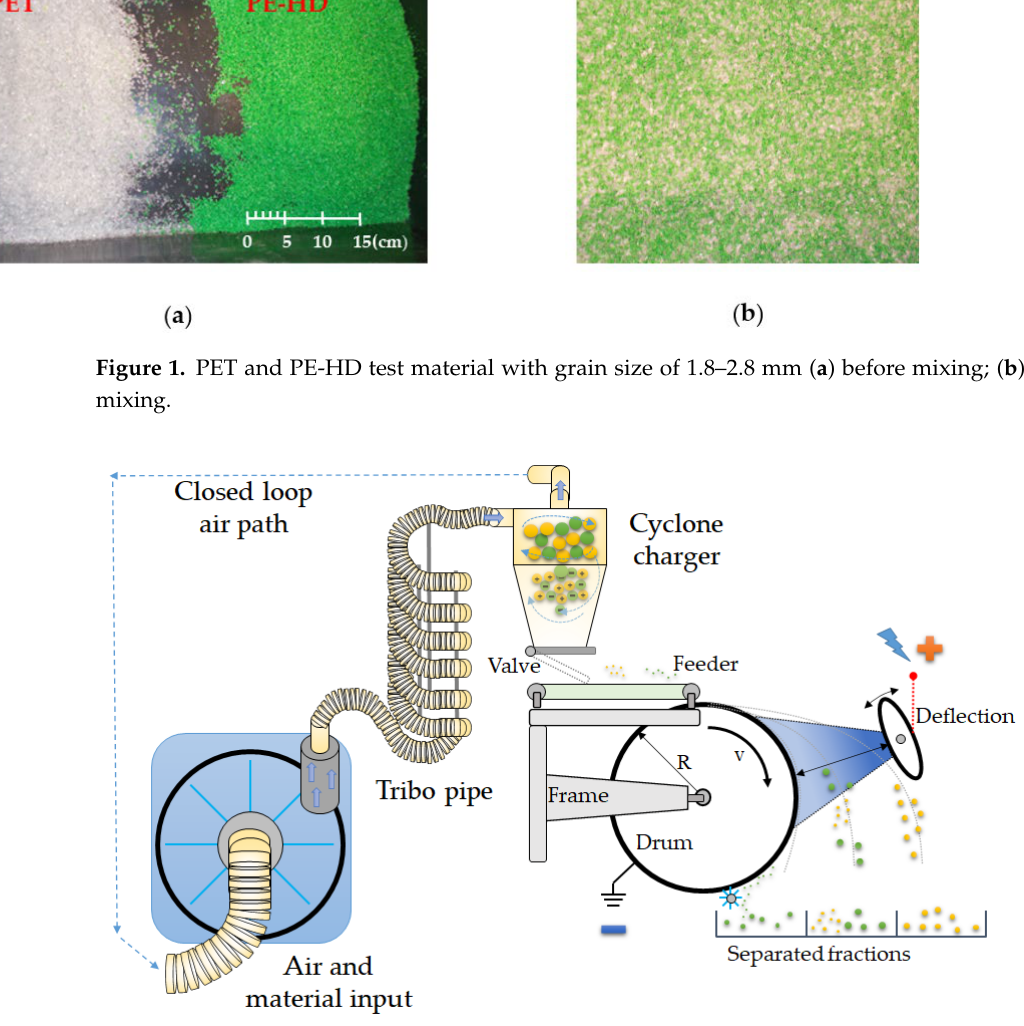
Figure 2. The automated test bench of the tribocharging and separation process.